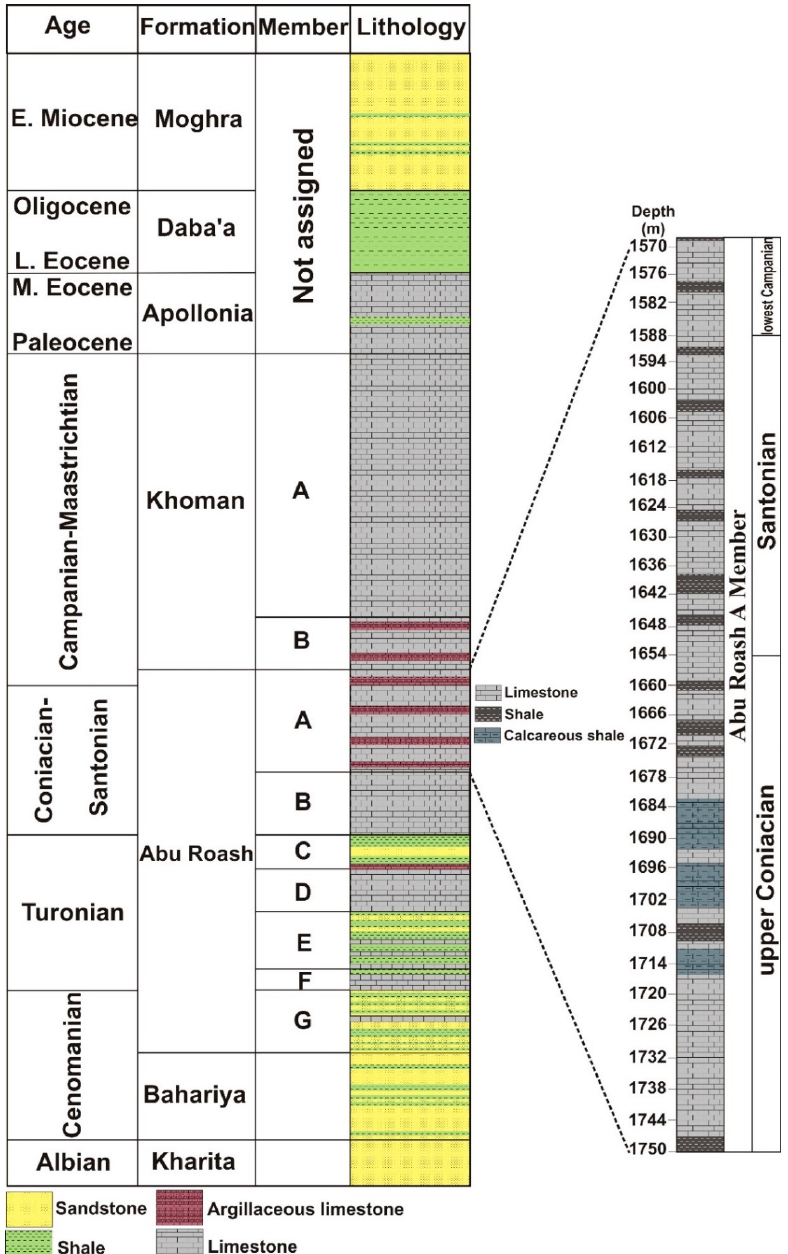
Figure 3. Complete lithologic column from the Albian to lower Miocene of the BED2-3 well that was drilled in the Abu Gharadig Basin, to the left. The lithologic column of the studied Abu Roash A Member (180 m), is expanded to the